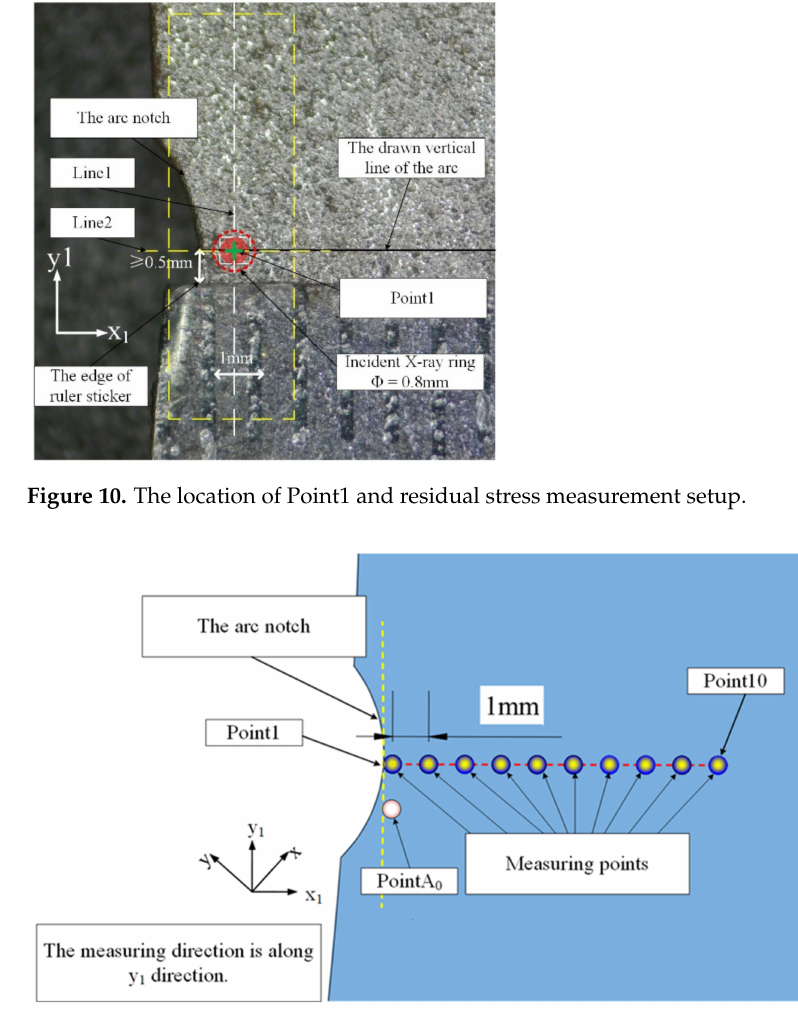
Figure 11. The schematic diagram of the measuring points at one shot–peened